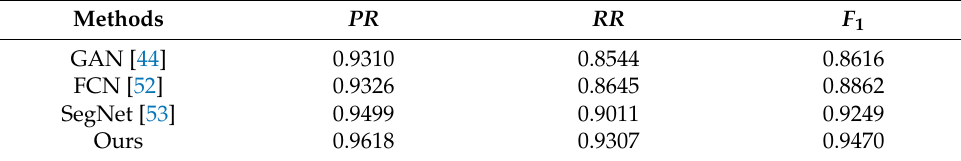
Table 4. A comparison between the proposed method with the existing models.